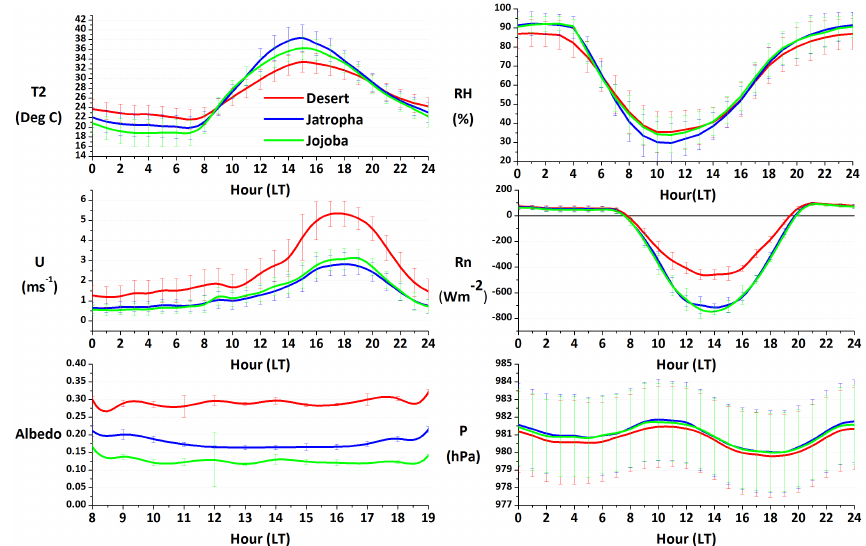
Fig. 4. Observed mean diurnal cycle of T 2, RH, U (6m), R n , albedo and P – 2012 (JJA). The error bars represent temporal standard